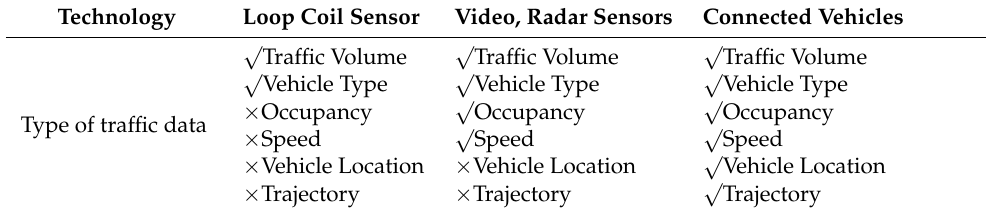
Table 1. Types of traffic data acquired by different sensors.